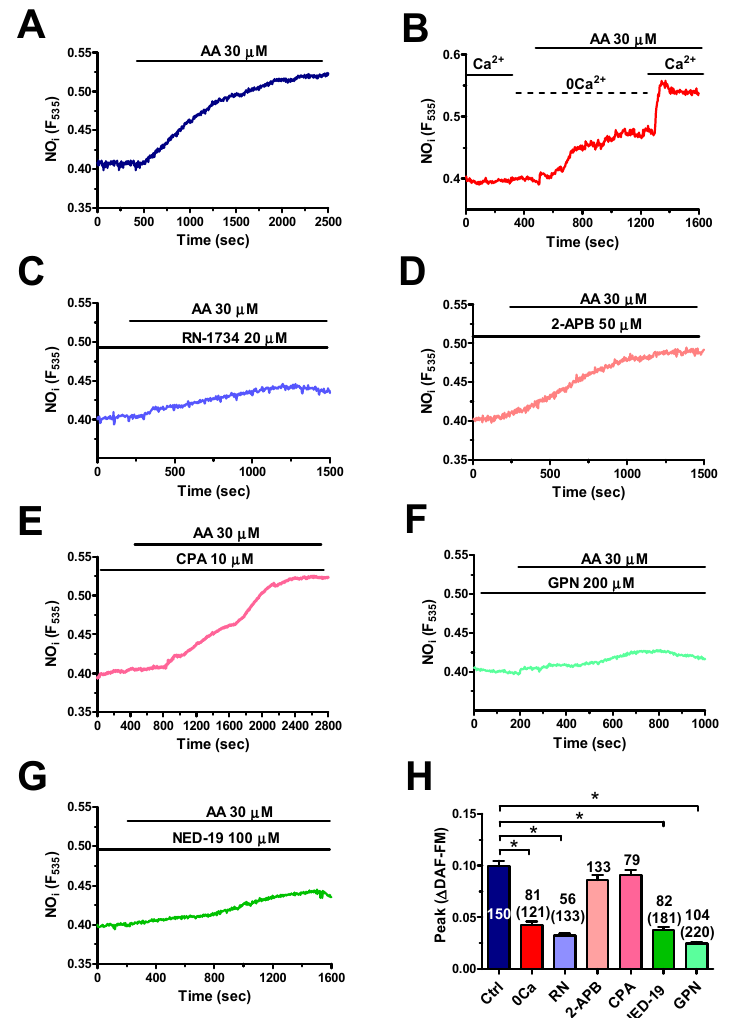
Figure 8. TPC1-2 and TRPV4 support arachidonic acid-induced NO production in hCMEC/D3 cells.